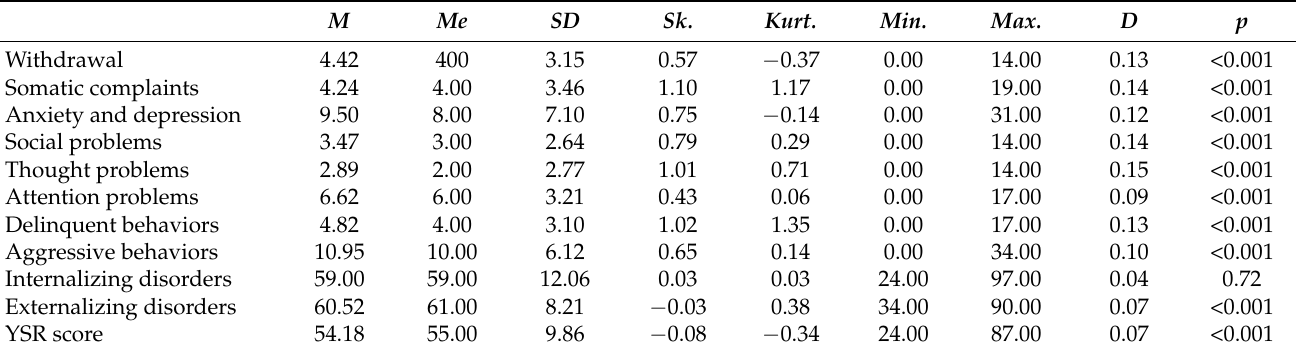
Table 2. Descriptive statistics and the distribution normality test.